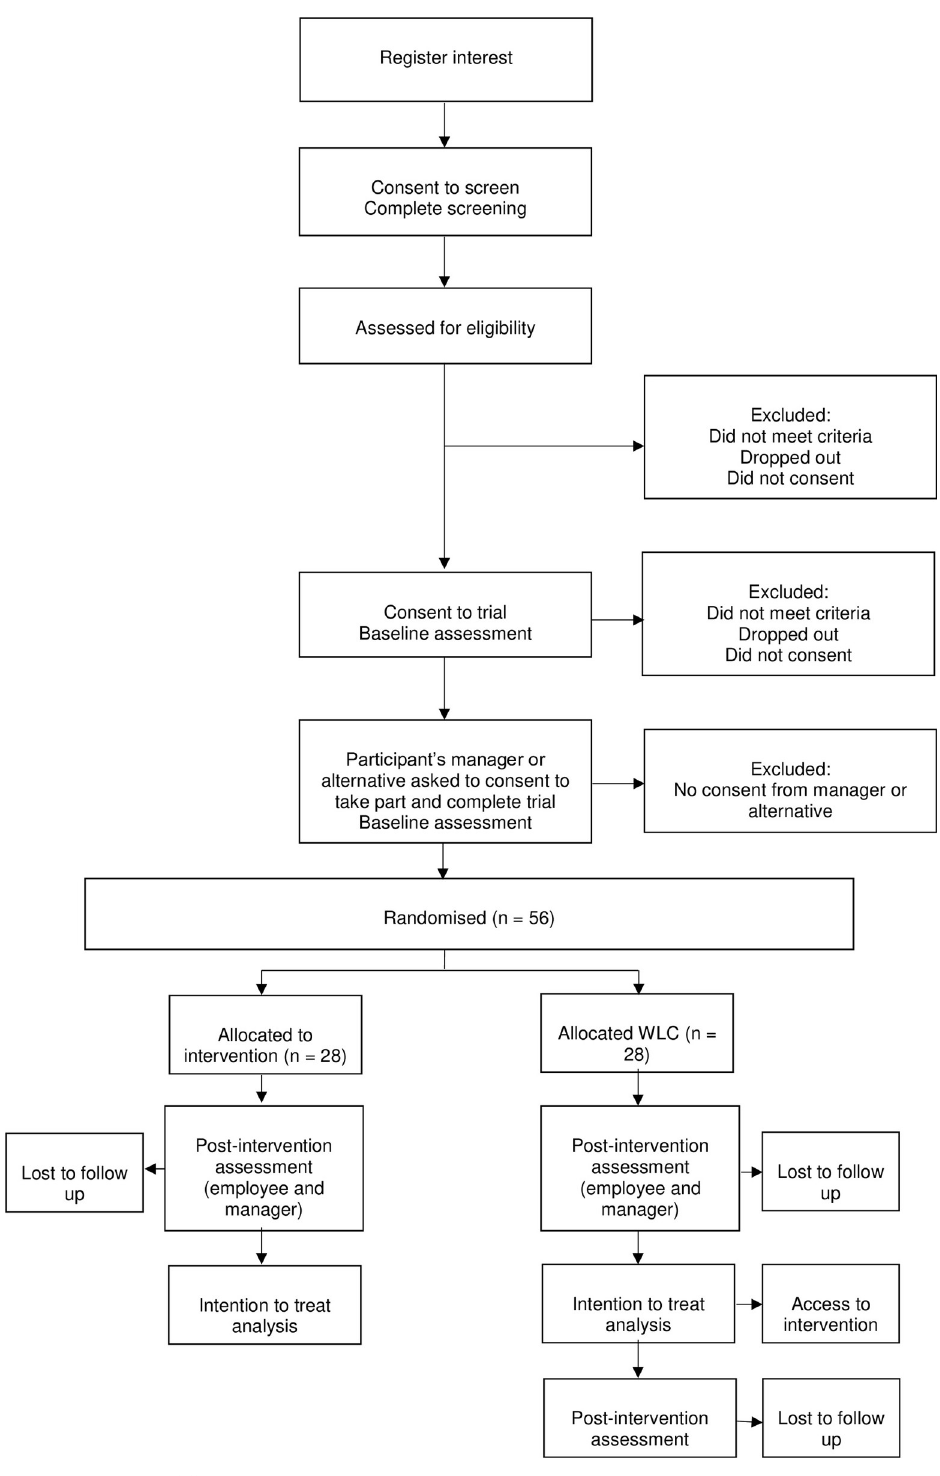
Fig 6. MENTOR trial